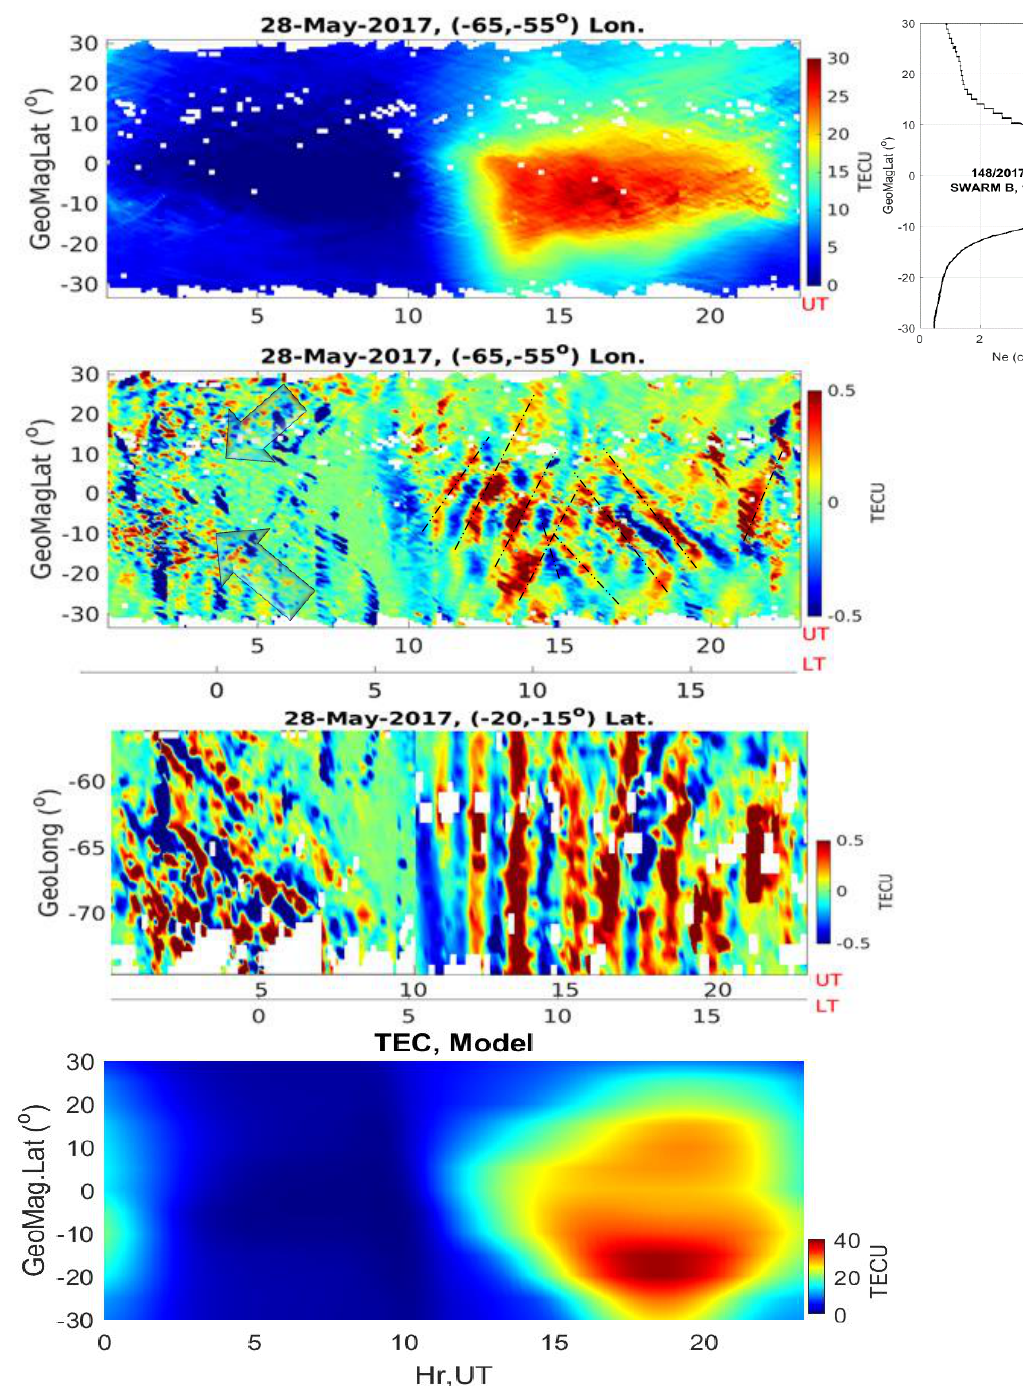
Figure 3. From top to bottom: keogram of background GNSS-TEC; on the right is the electron density obtained from the SWARM B satellite; keogram of TID obtained by removing the background TEC as a function of latitude and local and universal time (longitude: 55–65 ◦ S); keogram of TID as a function of longitude, local, and universal time on 28 May 2017; and the simulation of TEC using the thermosphere–ionosphere–electrodynamics general circulation model (TIEGCM) (at ± 30 ◦ geomagnetic